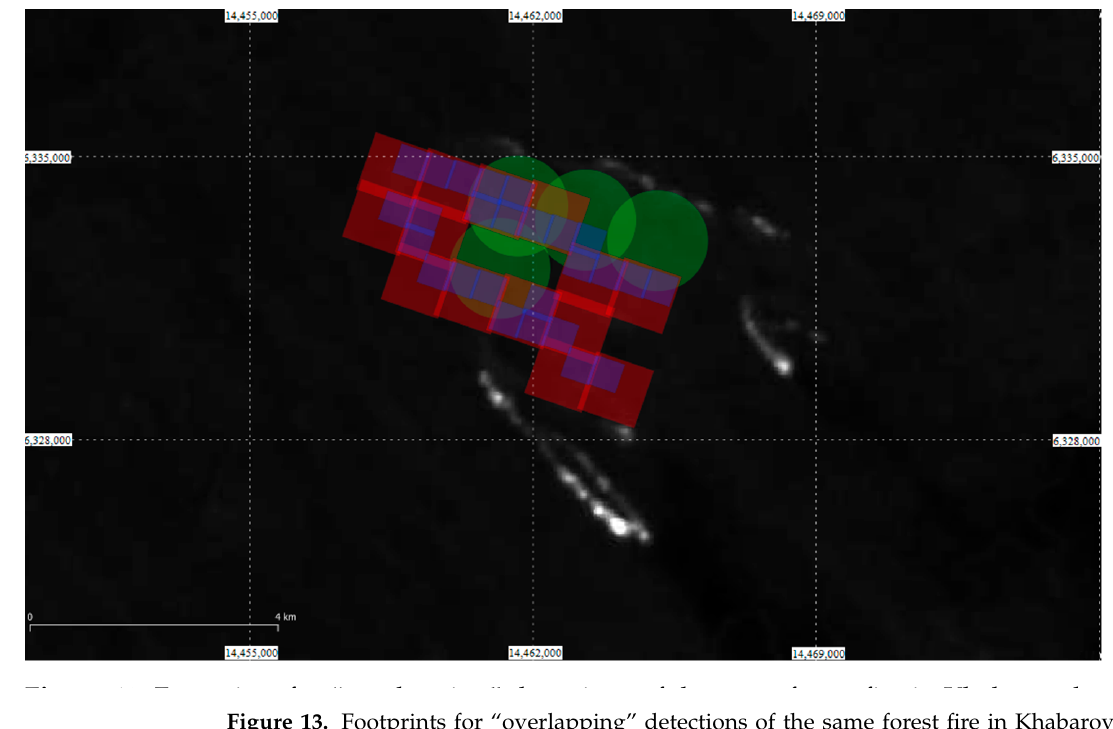
Figure 13. Footprints for “overlapping” detections of the same forest fire in Khabarovsk region at 49.353N 129.914E in EPSG:900913 projection observed with three satellites on 23 October 2015. Thermal background comes from the next night image at Band 8 from the Landsat 8 satellite path/row 116/26. Note the shift of the fire front between the satellite overpasses.